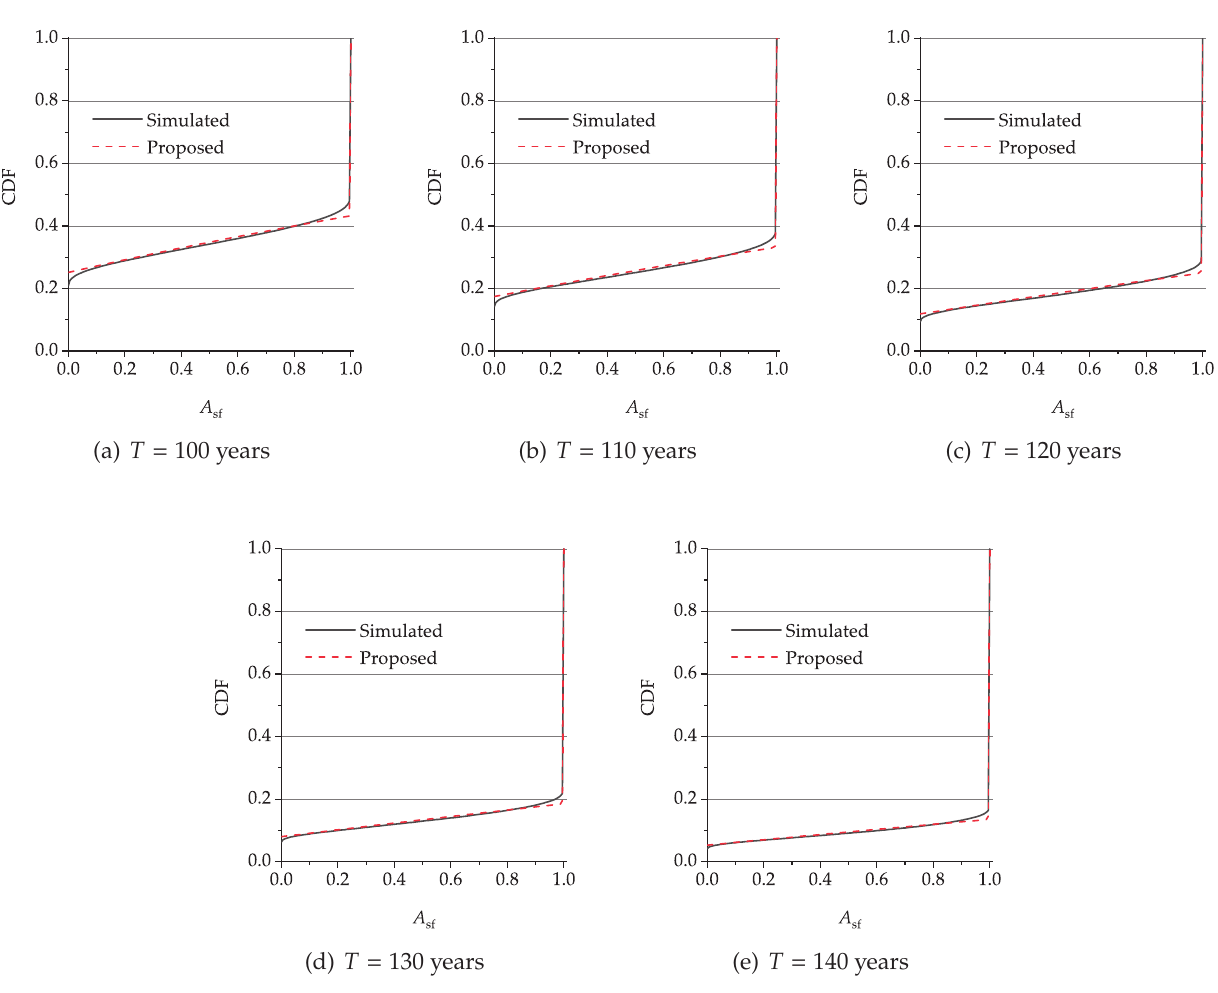
Figure 10. CDFs of A sf ( t ) by proposed and simulation-based methods ( µ ( x 0 ) = 50